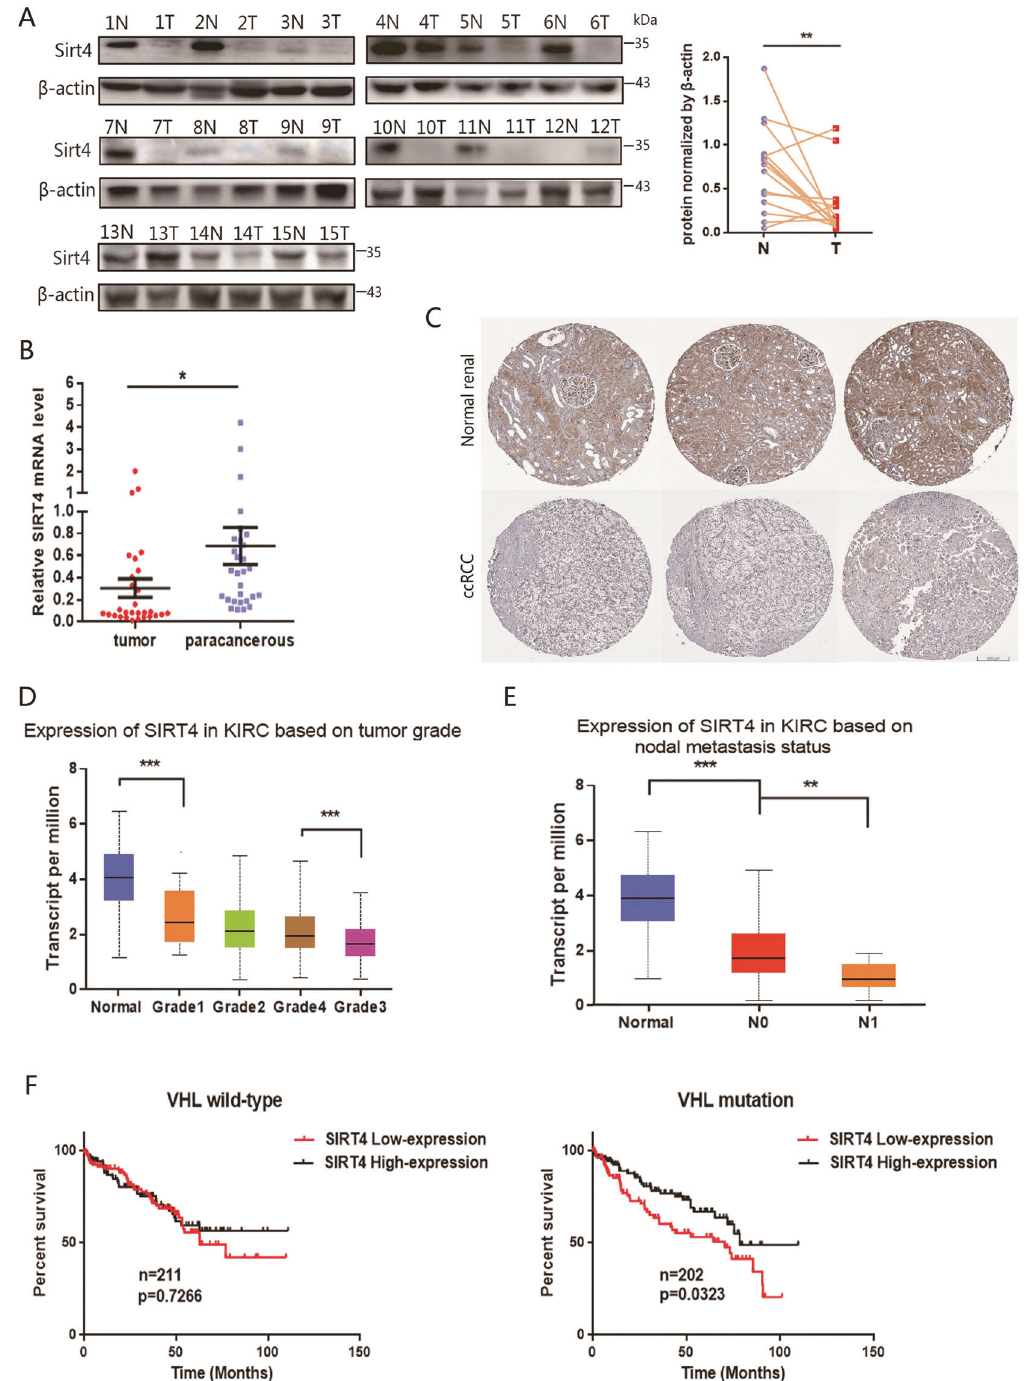
Fig. 2 Reduced SIRT4 expression associated with malignancies stage, grade, and prognosis. A The protein expression levels of SIRT4 in ccRCC patients were validated by western blot ( n = 15). β -actin serves as a loading control. A summary of the quanti fi cation analysis is shown on the right panel. B Relative mRNA expression of SIRT4 in ccRCC and normal tissues derived from our cohort ( n = 29). Data were presented as means ± SEM. C The expression intensities of SIRT4 in normal renal tissues and renal carcinoma specimens were detected by IHC. Images were taken from the Human Protein Atlas (http://www.proteinatlas.org) online database. The relative expression of SIRT4 based on tumor grade ( D ) and nodal metastasis status ( E ) were analyzed via the TCGA RNA-seq database. F The survival analysis was carried out on a cohort of KIRC form the TCGA database ( Nature , 2013). We classi fi ed the patients into two subgroups according to VHL status. Kaplan – Meier estimates of overall survival dependent on expression of SIRT4 (RNA-seq). Log-rank (Mantel – Cox) test was used to analyze OS. ** P < 0.01, *** P < 0.001.